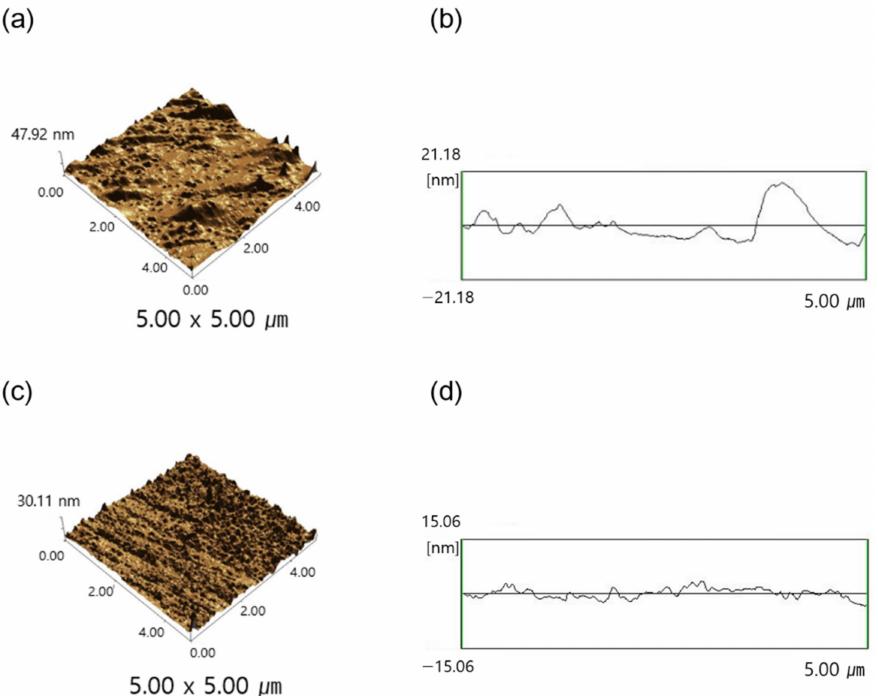
Figure 2. Surface properties of silsesquioxane-coated films. ( a ) 3D topographic AFM image of EPOSS film, ( b ) roughness of EPOSS film, ( c ) 3D topographic AFM image of EPSQ film, ( d ) roughness of EPSQ